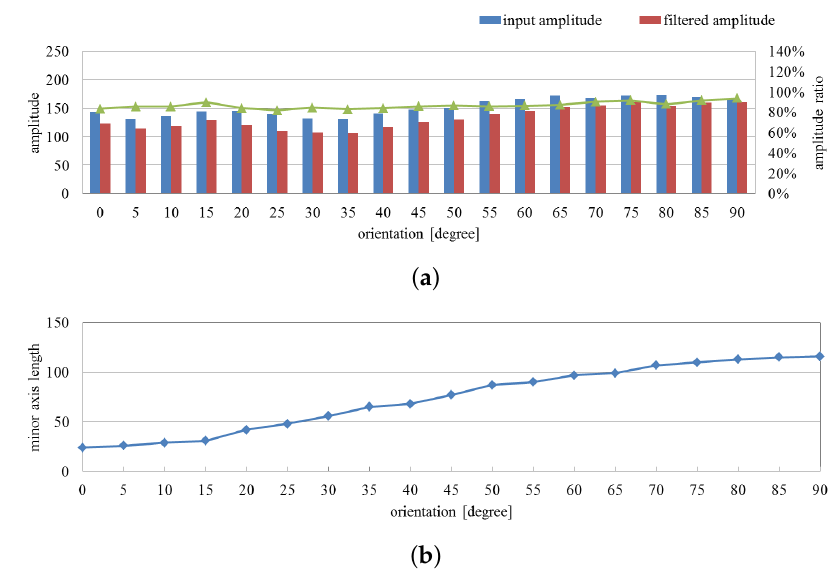
Figure 11. Averaged amplitude values and extracted region sizes with orientation variation. ( a ) Averaged amplitudes of input and pixel-wise filtered images and their ratios on the extracted pixels; ( b ) minor axis lengths of extracted vibration